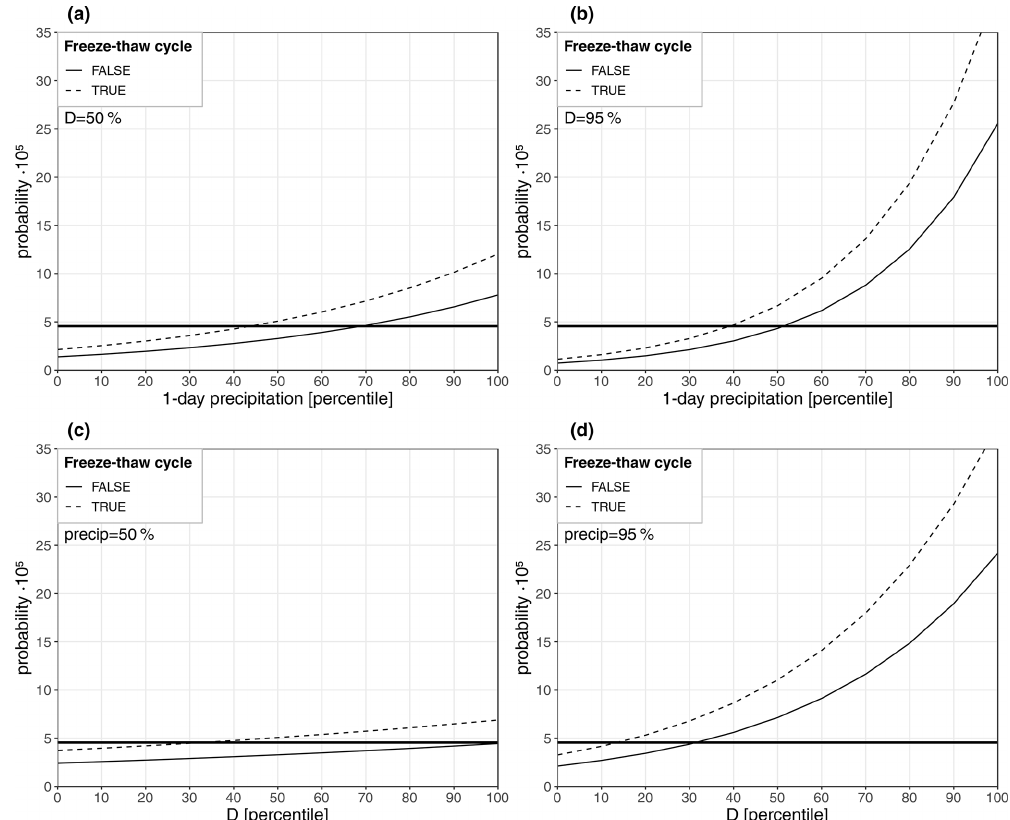
Figure 6. Probability for rockfall predicted by the logistic regression model. A dashed (solid) curve denotes the result for situations with (without) the occurrence of a freezing episode in the previous 3 weeks. The horizontal line marks the climatological probability. (a) Prob- ability as a function of the local percentile of daily precipitation. Constant median (i.e. 50th percentile) of the pore-water proxy D (i.e. precipitation minus potential evaporation for the previous 1-week period). (b) Probability as a function of the local percentile of daily pre- cipitation. Constant 95th percentile of D . (c) Probability as a function of the percentile of D . Constant median (i.e. 50th percentile) daily